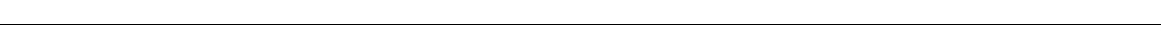
Fig. 9 Intrathecal delivery of miR-21-5p antagomir reduces immune cell recruitment and number of M1 macrophages in DRG following SNI injury. Representative scatterplots of immune cells sorted from pools of contralateral and ipsilateral L4 and L5 DRG obtained from SNI mice intrathecally treated with scrambled oligomer ( a ) or miR-21-5p antagomir ( b ) as in Fig. 8. Cells were gated on CD45 + , F4/80 + , and CD11b + . Macrophages were de fi ned as CD11b + F4/ 80 + and further analyzed for the M2 (CD206 + CD11c − ) and M1 (CD206 − CD11c + ) phenotypes as indicated by arrows. Numbers in gates refer to the percentage of positive cells for each speci fi c marker. Bar charts represent absolute number in DRG of leukocytes (CD45 + ; c ), macrophages (CD11b + F4/80 + ; d ), M1 macrophages (CD206 − CD11c + ; e ), and M2 macrophages (CD206 + CD11c − ; f ). Statistical analysis was performed on data obtained from four independent experiments. Data are means ± S.E.M., n = 4 for each group. ** P < 0.01 and *** P < 0.001, one-way ANOVA, post hoc